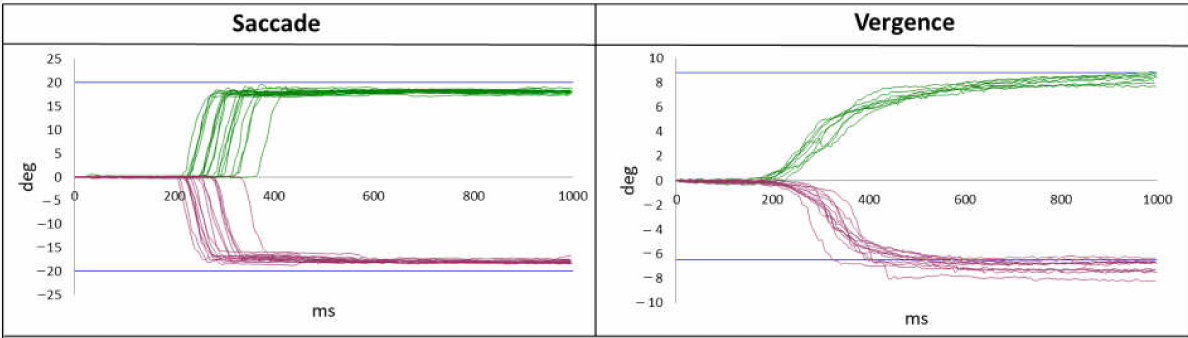
Figure 3. The kind of results given by the AIDEAL software, permitting a quick overview of the results for vergence and the saccade sequence with time in ms on the X-axis and degrees on the Y-axis. The green curves represent the convergence and right saccades. The purple curves represent divergence and left saccades. Each curve represents one